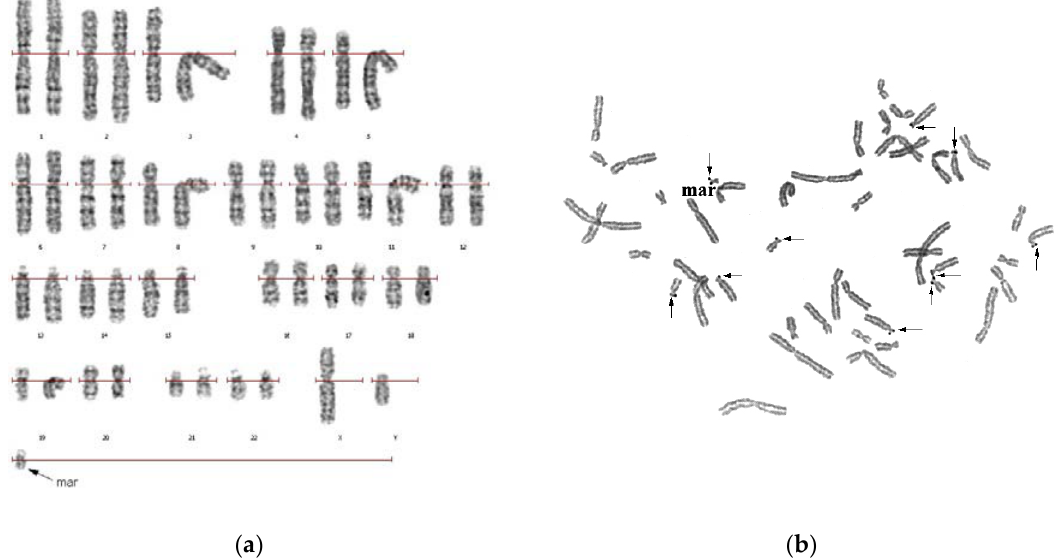
Figure 10. The karyotype of the patient. ( a ) GTG-differentially stained chromosomes of the patient with small supernumerary marker chromosome (sSMC) in the karyotype. ( b ) Metaphase plate of a patient with AgNOR-staining (case 2). → —arrow indicates nucleolus organizer region (NOR) detected on acrocentric chromosomes and sSMC on the patient’s sSMC by AgNOR-staining. mar—indicates sSMC.